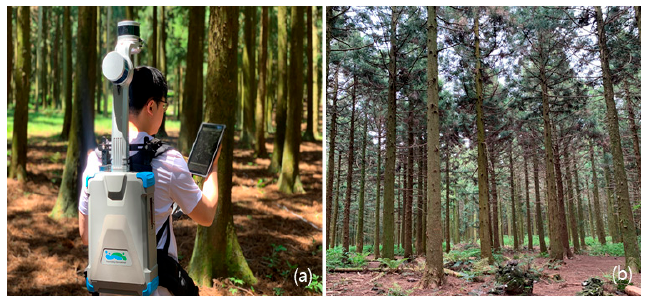
Figure 2. Photograph of survey using Libackpack D50 ( a ) and the Saryeoni forest ( b ).